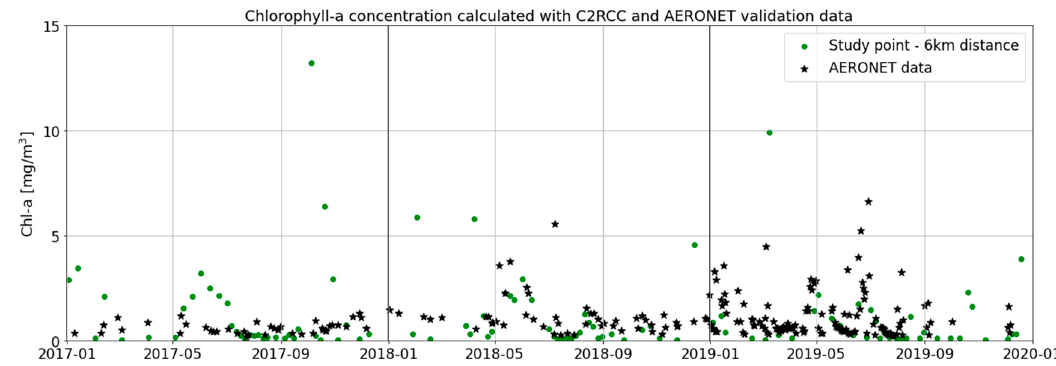
Figure 2. Chlorophyll-a concentrations in (mg/m 3 ) in the period 2017–2019. Black stars represent the data from the AERONET-OC Galata site and the green dots are the concentrations calculated with the C2RCC processor for the nearest study point.